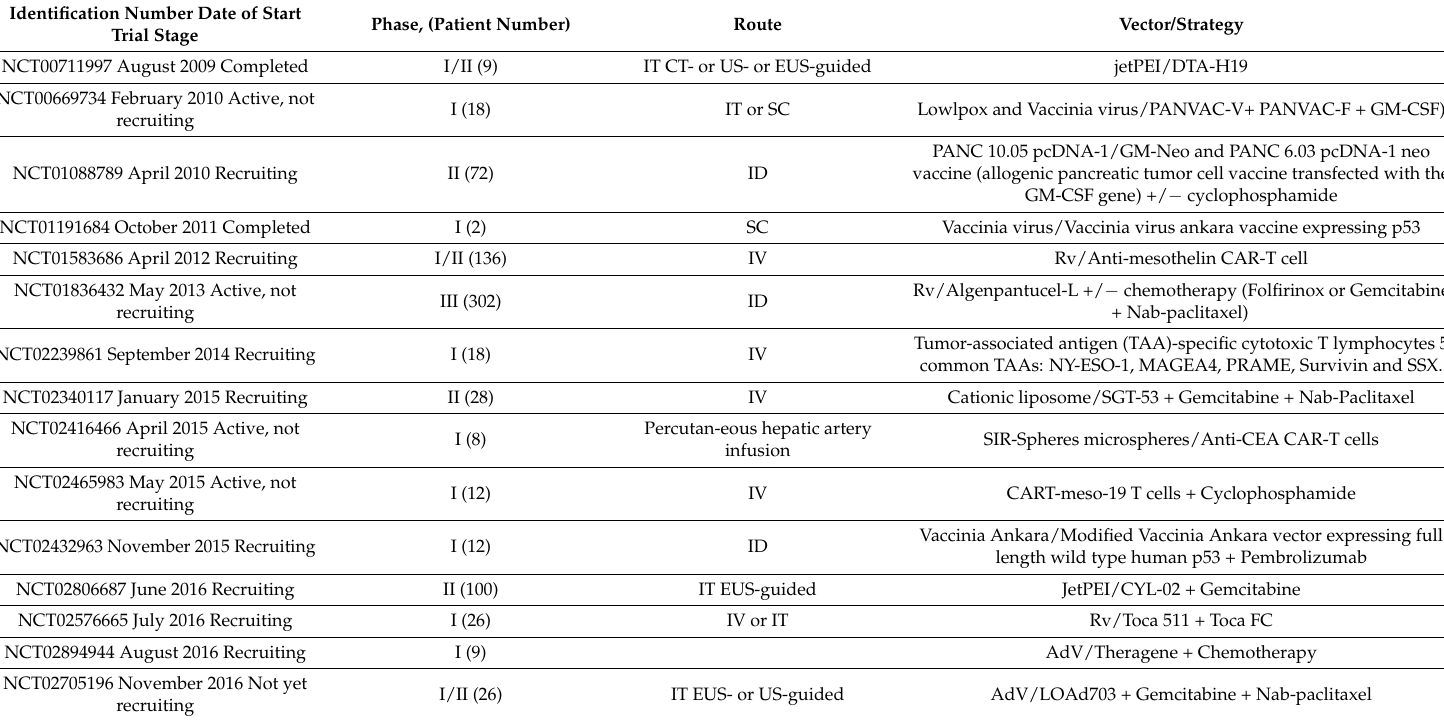
Table 4. Main on-going clinical trials of gene therapy for pancreatic cancer (source ClinicalTrials.gov, available online: